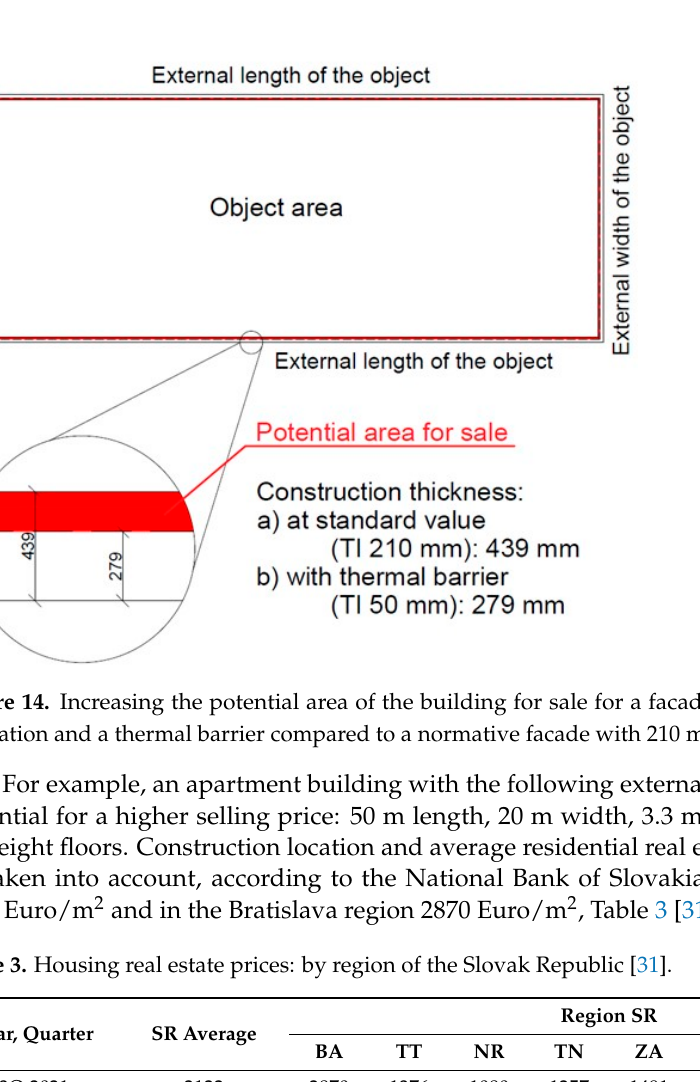
Table 3. Housing real estate prices: by region of the Slovak Republic [31]. Year, Quarter SR Average